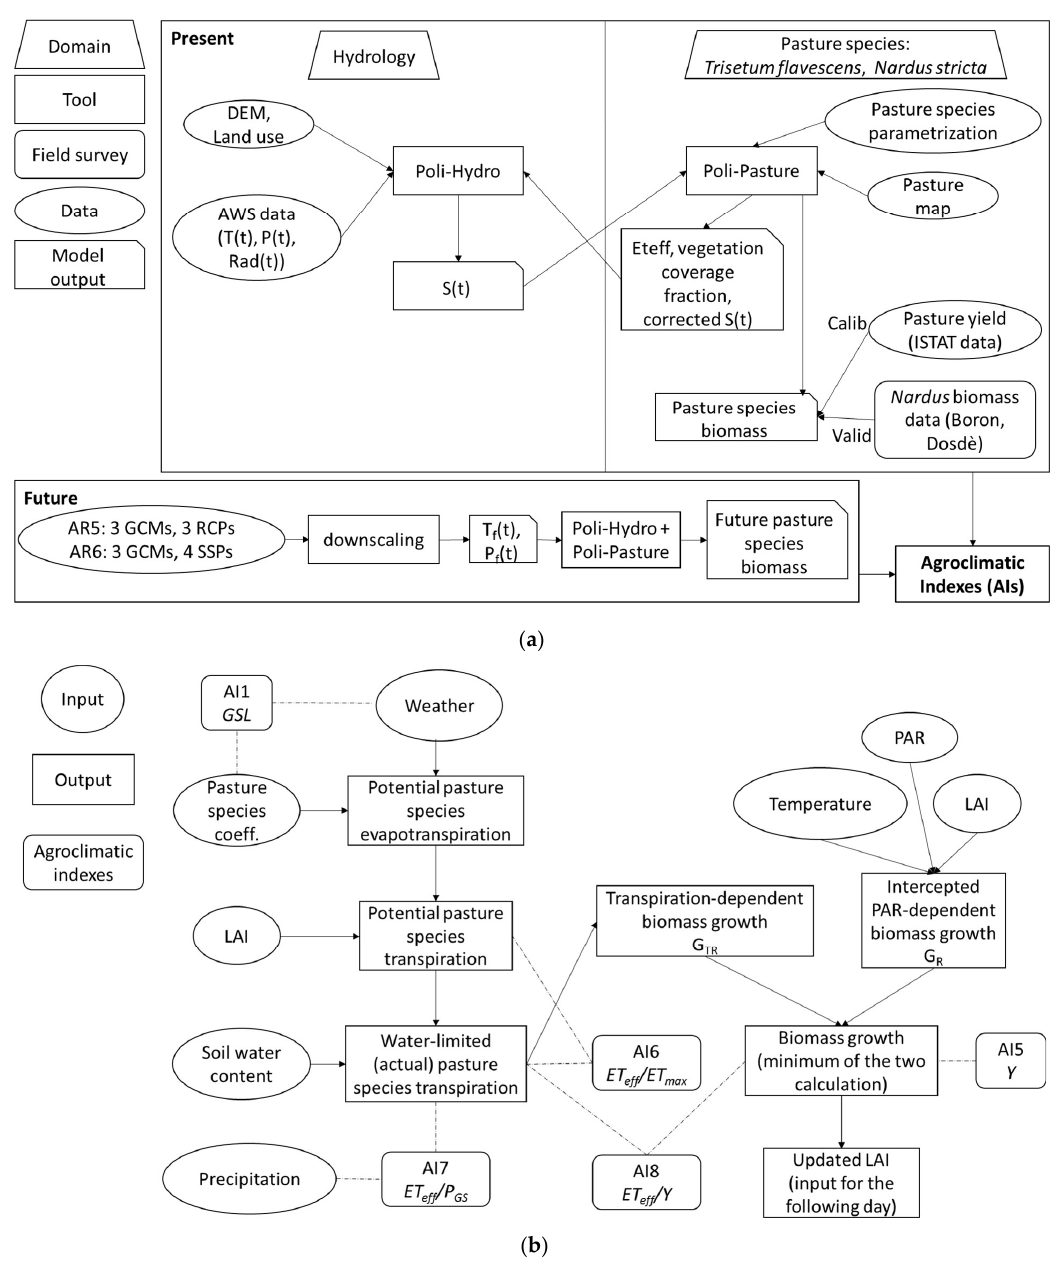
Figure 2. ( a ) Flow chart of the methodology: the setting is presented on the top left. Poli-Hydro (hydrology) and Poli-Pasture (pasture growth) components and interconnections are reported in the frame on the top, named “present”. Generation of future projections is presented in the frame below, called “future”. T , P, and Rad are meteorological data: temperature, precipitation, and radiation, respectively. S(t) is the soil water content, and ETeff is actual evapotranspiration. ( b ) Detailed flow chart of Poli-Pasture model: depicting operation at a generic time step t. Inputs are data, Poli-Hydro-simulated variables at time step t, and Poli-Pasture-simulated variables at the previous time step. Outputs are used for the agroclimatic indices calculation and as input to Poli-Hydro and Poli-Pasture at the following time step.